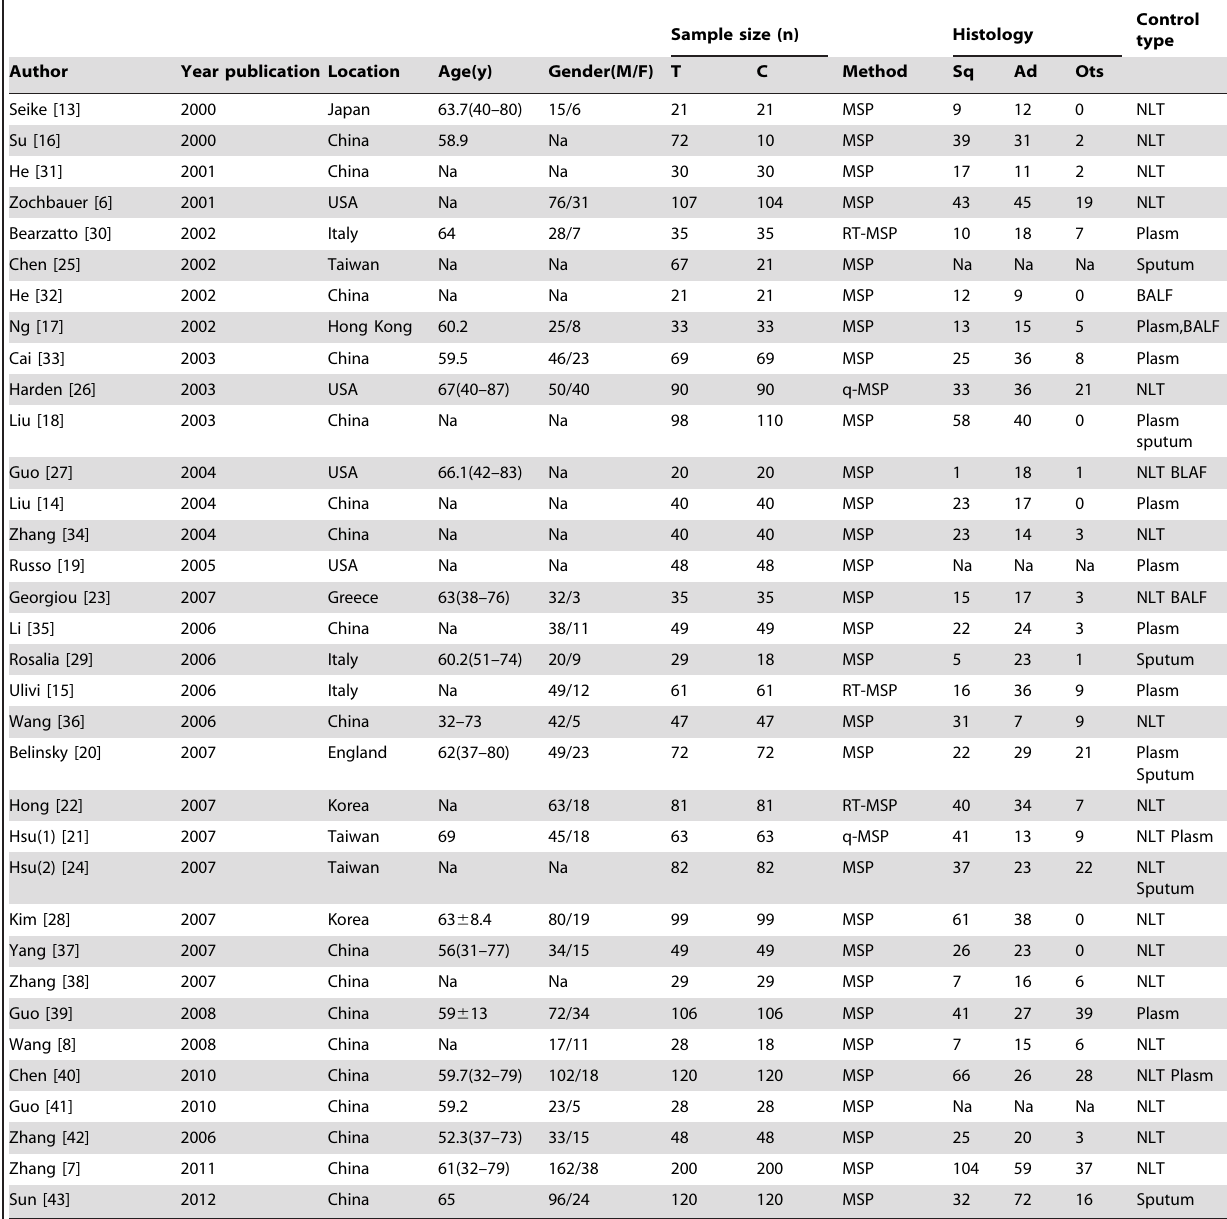
Table 1. General characteristics of included